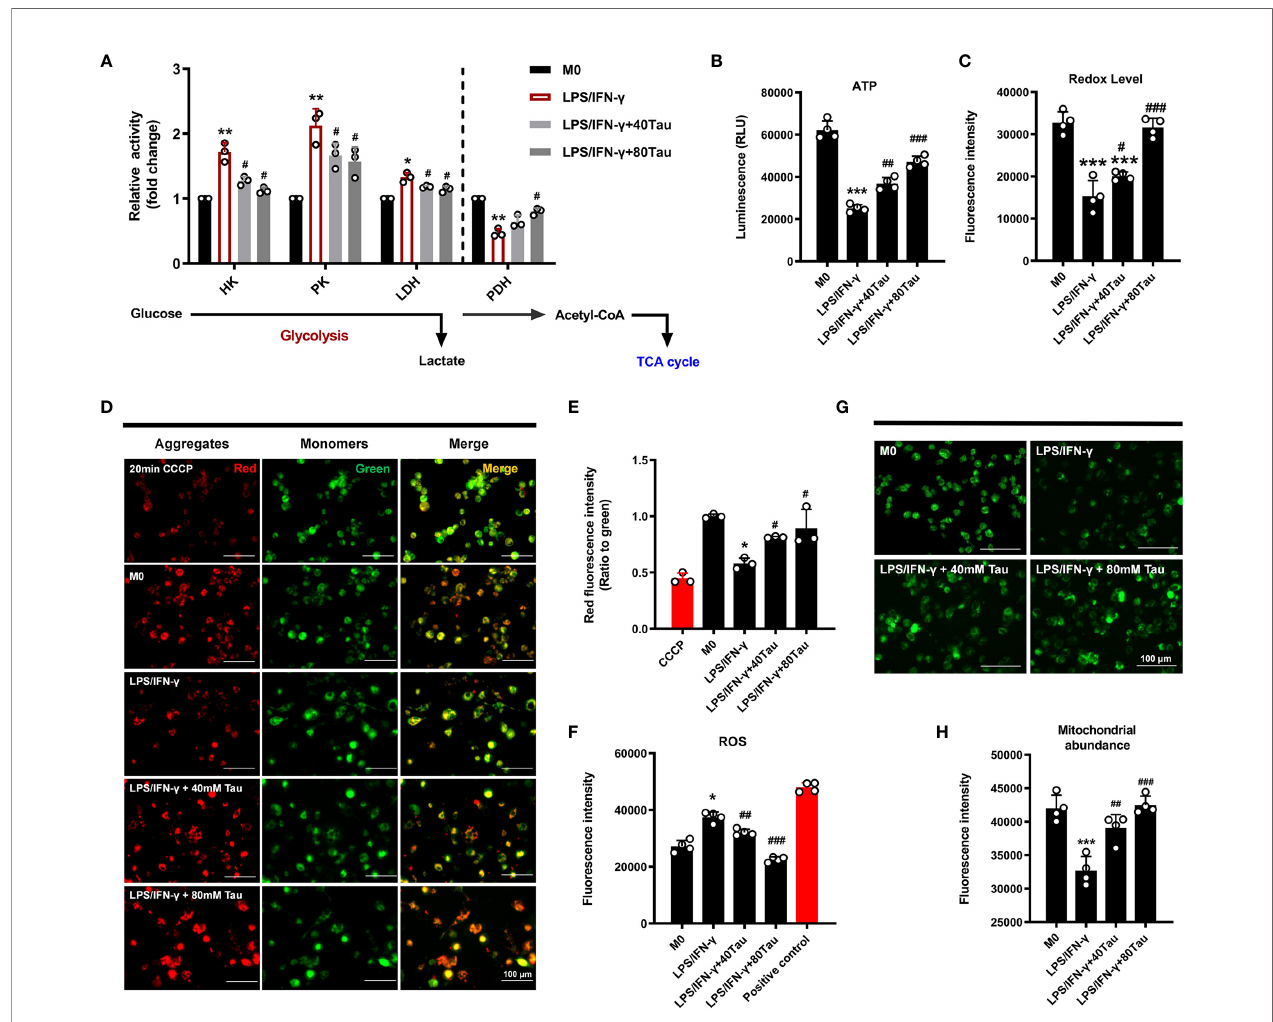
FIGURE 3 | Taurine reprograms the energy metabolism of macrophages. (A) Activities of glycolysis enzyme and PDH, n=3. (B) The levels of ATP, n=4. (C) alamarBlue assay, n=4. (D – F) Taurine up-regulates mitochondrial membrane potential and reduces the level of ROS in LPS/IFN- g -challenged macrophages, n=4. (G, H) Fluorogram and quantitative analysis of mitochondrial abundance, n=4. *p < 0.05, **p < 0.01 and ***p < 0.001 vs. M0; #p < 0.05, ##p < 0.01 and ###p < 0.001 vs. LPS/IFN- g